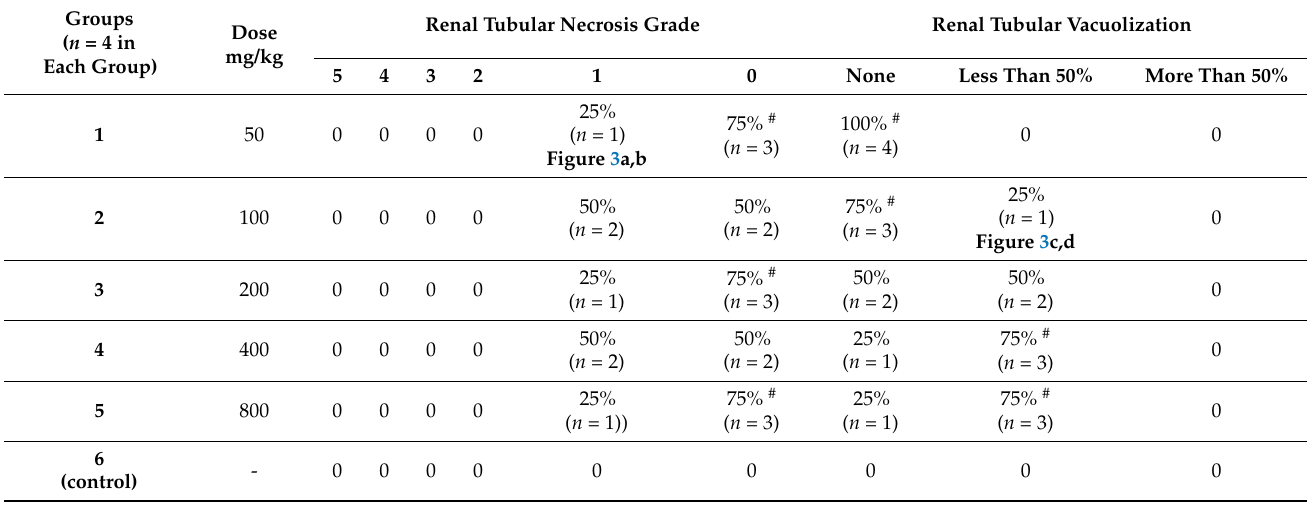
Table 3. Renal tubular necrosis and vacuolization in acute toxicity study. ( n = 24). Groups ( n = 4 in